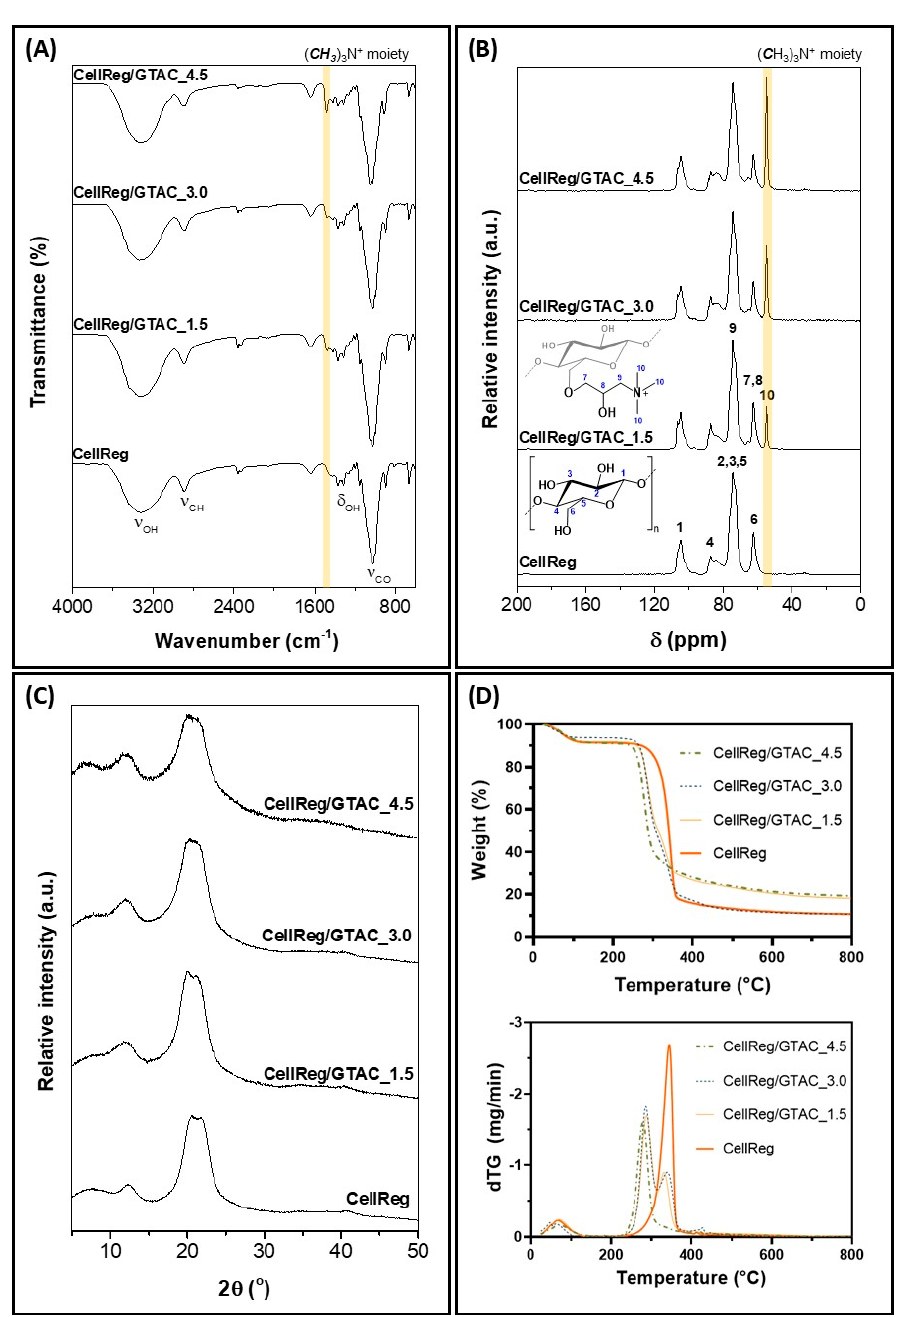
Figure 2. ( A ) FTIR-ATR spectra (vibrational modes: ν = stretching and δ = bending), ( B ) 13 C CP/MAS NMR spectra, ( C ) XRD diffractograms and ( D ) TGA thermograms (up) and derivative (dTG) curves (down) of the non-modified and modified regenerated cellulose samples: CellReg, CellReg/GTAC_1.5, CellReg/GTAC_3.0 and